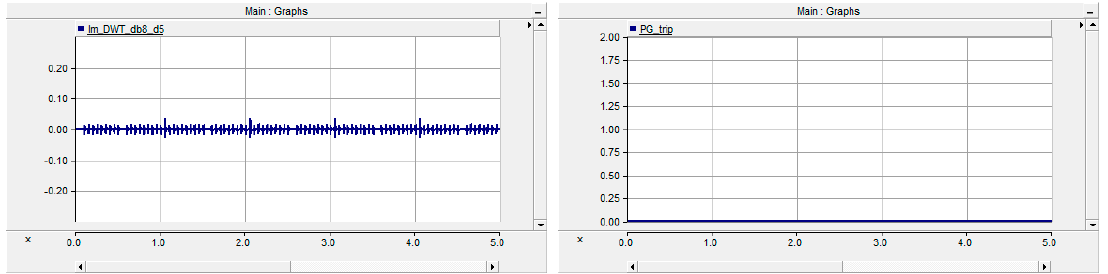
Figure 11. The simulation result under load change.